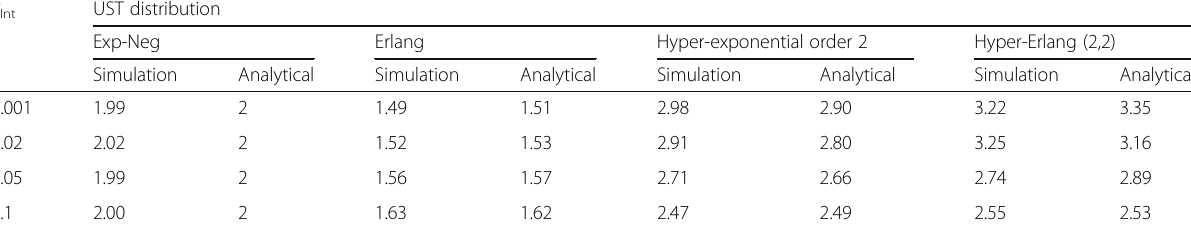
Table 5 Skewness of the CHTn for different distributions of the UST when CDT is exponentially distributed P Int UST